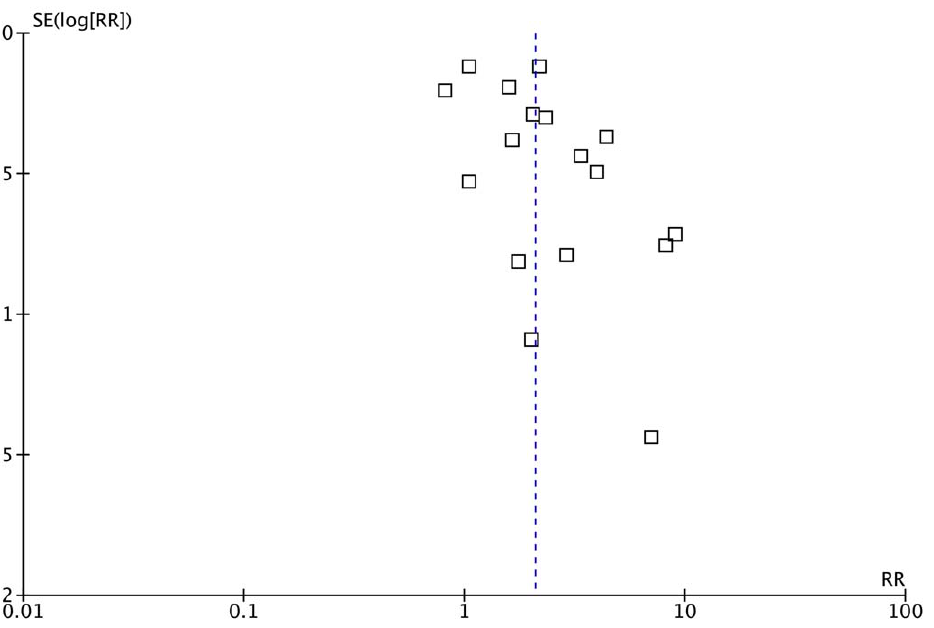
Figure 2. Funnel Plot for Publication Bias. This funnel plot was used to assess whether publication bias was potentially present in our meta- analysis.